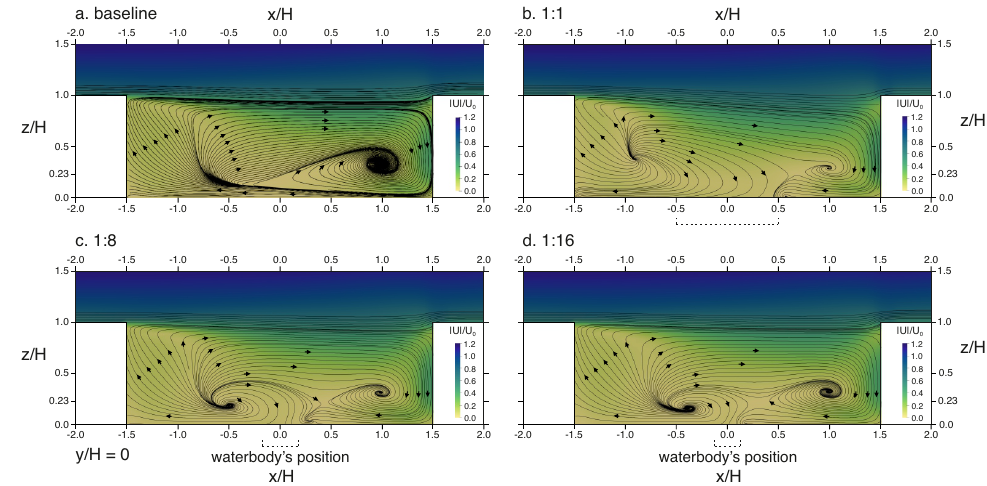
Figure 6. Velocity streamlines for the cases with a cooler water body ( ∆ T = − 2 K) with different sizes over a vertical plane at y / H = 0 in the open square ( − 1.5 ≤ x / H ≤ 1.5). Normalised velocity magnitude is depicted spatially in the background: ( a ) baseline scenario; ( b ) original size ( S_1:1 );